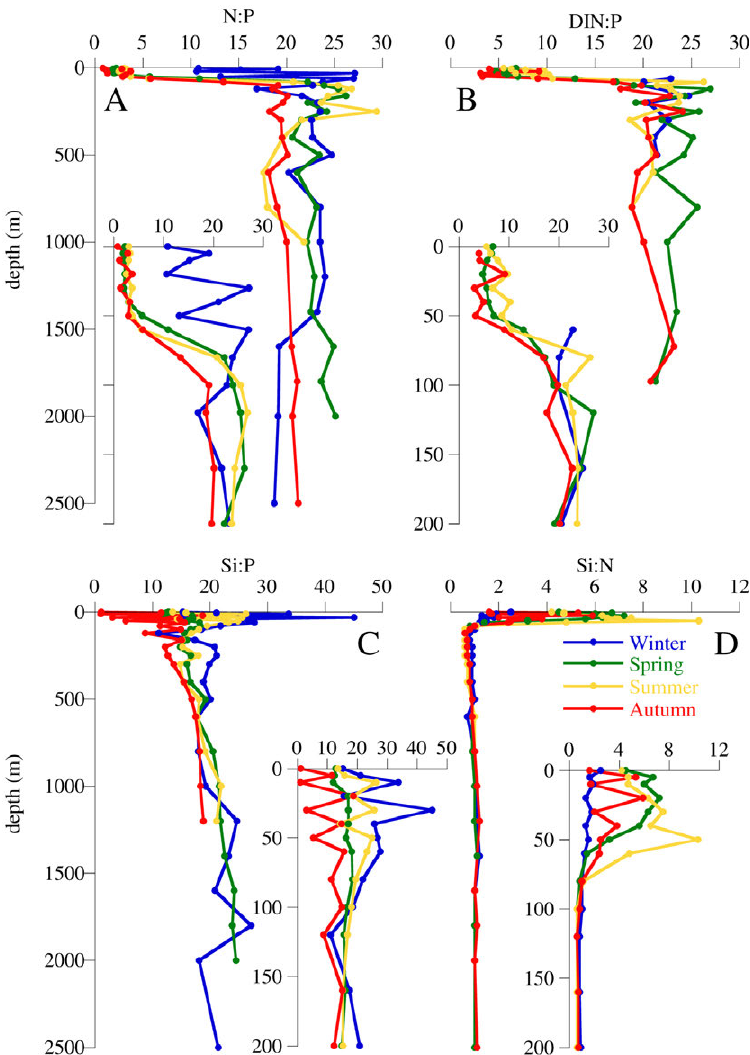
+NH ):P (B), Si:P (C), and Si:N (D) at 2+3 4